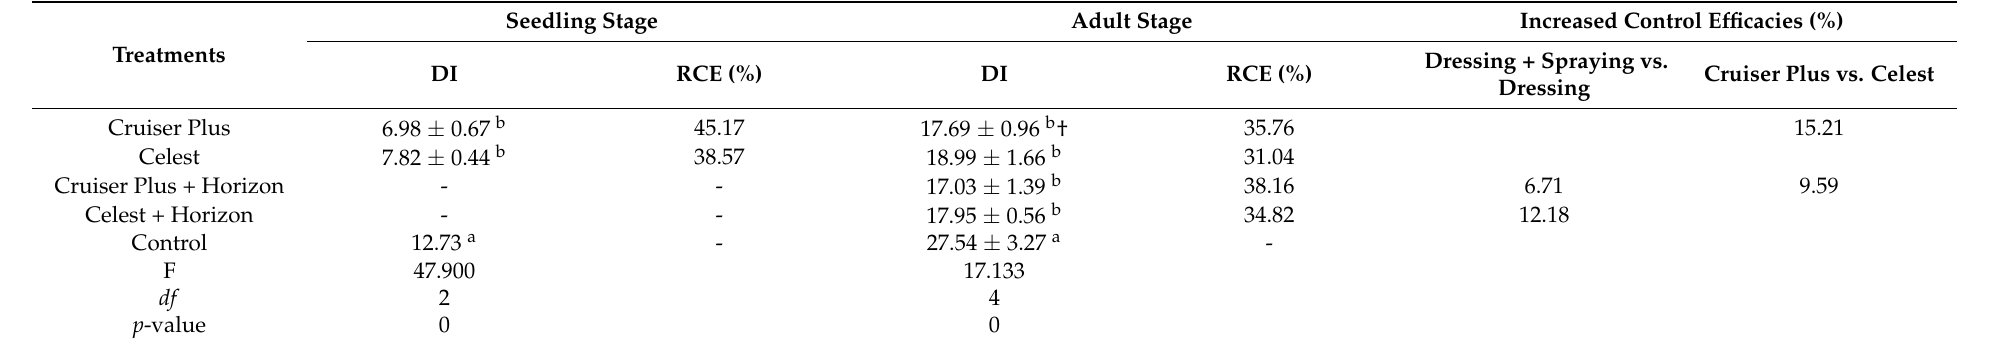
Table 5. Relative control efficacy of the two agents in the field and their combined treatments (Linzhang 2017).